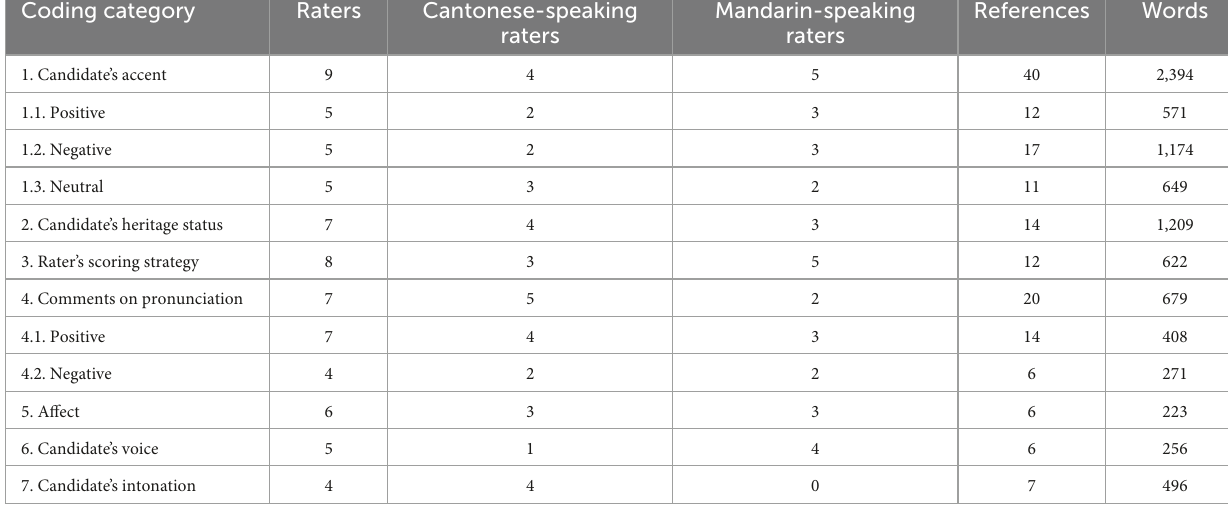
TABLE 3 Summary of coding